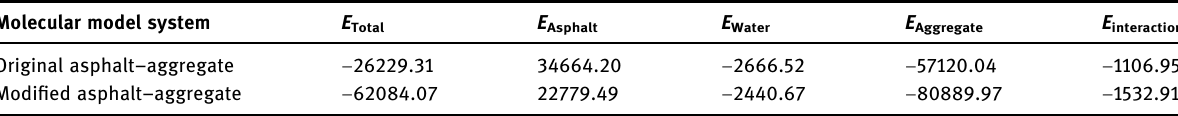
Table 2: Simulation results of interfacial energy between asphalt and aggregate ( kJ · mol − 1 ) Molecular model